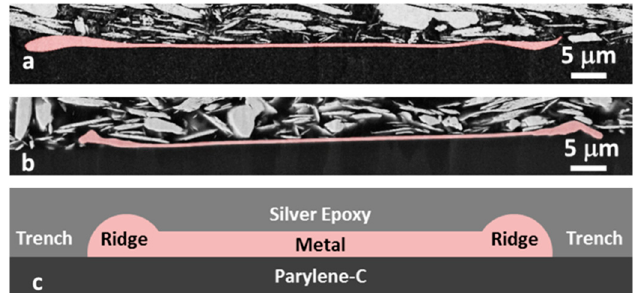
Figure 8. The color enhanced, dewetted ridge profiles of 100 μ m pitched line arrays for a cross section of a single digit in ( a ) Bi-Ag and ( b ) Ni-Ag layered target films. A diagram of the ( c ) film structure has been provided for clarity. The flakes in the image are related to the Ag conductive epoxy used for the specimen preparation.